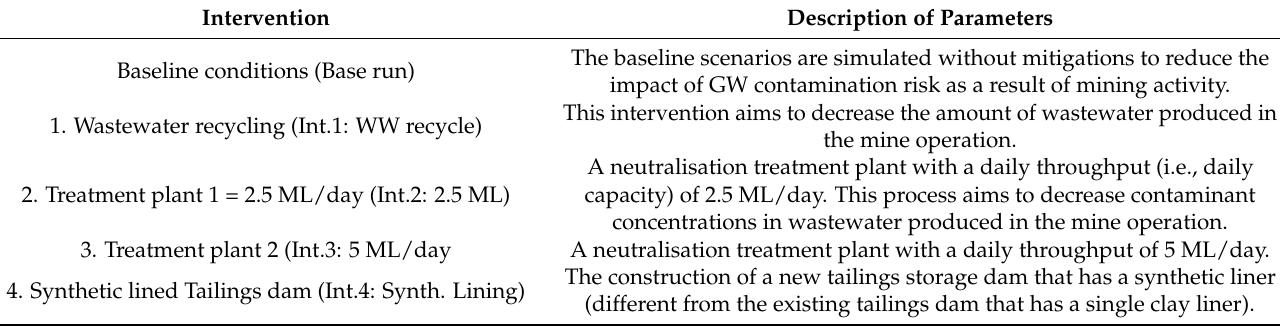
Table 4. Description of simulation runs of intervention scenarios.